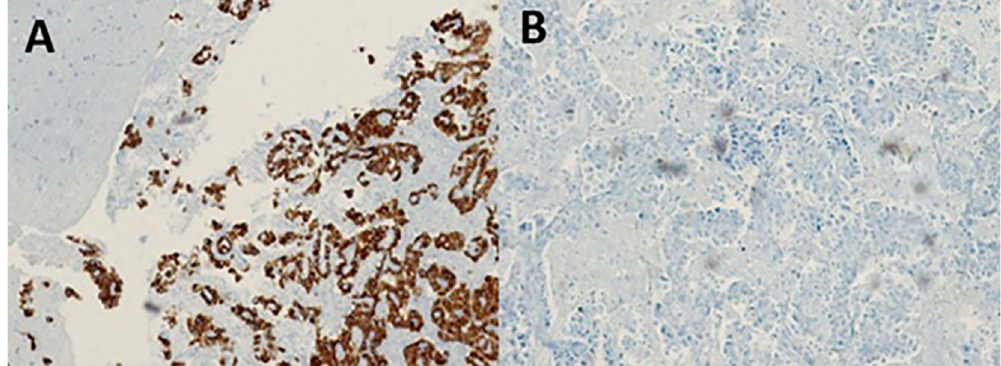
Figure 3. Pathology slides with immunohistochemistry and markers used in unknown primary adenocarci- noma and corresponding to lung adenocarcinoma: A. Atypical cells in the leptomeningeal region with positive staining for CK7; B. Atypical cells in the leptomeningeal region with negative staining for CK20.